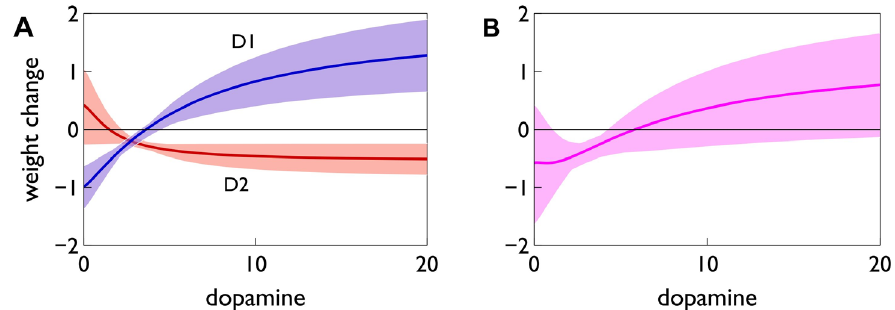
Figure 13. Expected overall weight change as a function of dopamine concentration. Here we plot the mean (line) and range (shading) of the overall weight change (sum of the plasticity factors K z ( d ) z K { ( d ) ) at a given dopamine level d , across every set of plasticity coefficients found by the search (Figure 10). (A) Separate plots for the found sets of D1 and D2 MSN coefficients, showing the dopamine dependence of each neuron type. (B) The sum of the individual MSN-type contributions in